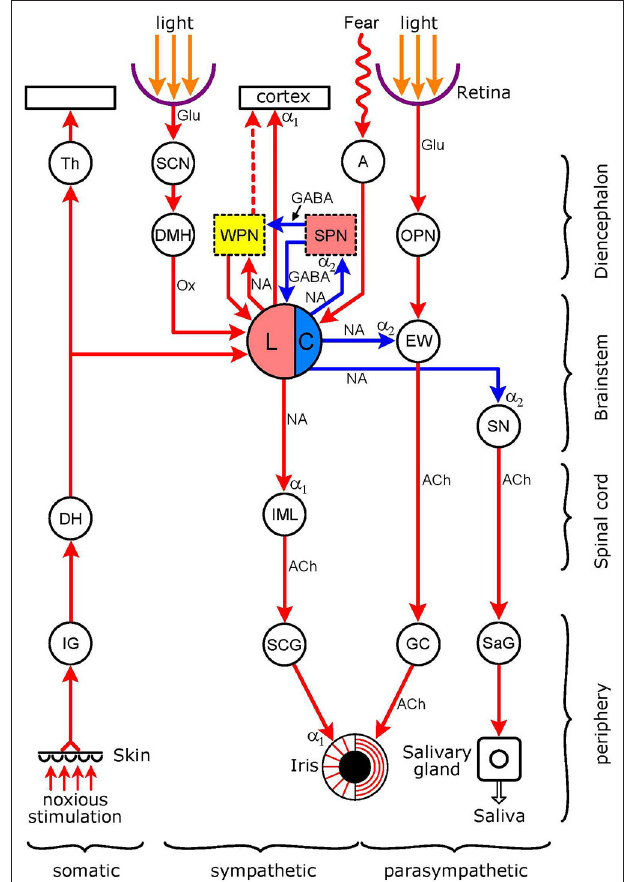
FIGURE 2 | Connections of the light-stimulated noradrenergic pathway. The encircled areas represent nuclei and ganglia. Diencephalon Th (thalamus); SCN (suprachiasmatic nucleus of hypothalamus); DMH (dorso-medial hypothalamus). WPN (yellow): wake-promoting nuclei (basal forebrain, thalamus, pedunculopontine tegmental nucleus, tuberomamillary nucleus. ventral tegmental area, dorsal raphe nucleus); SPN (pink): sleep-promoting nuclei (ventrolateral preoptic nucleus of hypothalamus, basal forebrain). A, amygdala; OPN, olivary pretectal nucleus. Brainstem : LC, locus coeruleus (pink: excitatory sympathetic premotor neurones, blue: inhibitory parasympathetic premotor neurones); EW (EWN in text: Edinger-Westphal nucleus); SN, salivatory nucleus. Spinal cord : DH (dorsal horn); IML (intermedio-lateral column). Peripheral ganglia : IG (intervertebral somatosensory ganglion); SCG (superior cervical ganglion); GC (ganglion ciliare); SaG (salivatory ganglion). Connections are shown by arrows: red–excitatory; blue–inhibitory. Neurotransmitters : Glu (glutamate); GABA (y-amino-butyric acid); Ox (orexin); NA (noradrenaline); ACh (acetylcholine). Adrenoceptors (postsynaptic): α 1 (excitatory); α 2 (inhibitory). The excitatory sympathetic premotor neurones in the LC are stimulated by light (via the retina → SCN → DMH → LC pathway), by pain (via collaterals from the spino-thalamic tract), and via inputs from WPN during wakefulness; this would lead to an increase in sympathetic outflow to the iris (LC → IML → SCG → dilator pupillae muscle), manifesting as pupil dilation. The excitatory sympathetic premotor neurones in the LC are inhibited by SPN during sleep, leading to a reduction in sympathetic outflow to the iris, manifesting as pupil constriction. The inhibitory parasympathetic premotor neurones in the LC can be activated by fear and anxiety, via an input from the amygdala, leading to enhancement of the inhibition of parasympathetic preganglionic neurones in the EW (inhibition of light reflex: retina → OPN → GC → sphincter pupillae muscle pathway) and in the SN (reduction in salivary output: SN → SaG → salivary gland pathway). For WPN and SPN, see Szabadi (6). See text for